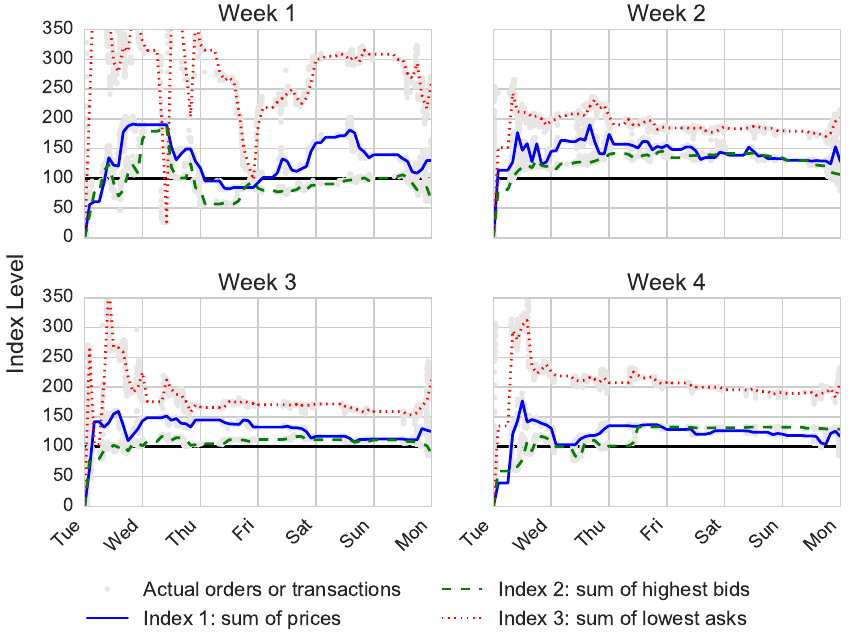
Figure A.3: Experiment 1: Evolution of the sum of all security prices for the four weeks of trading. The sum of all security prices should be 100 but there were several pronounced deviations from this normative prediction. The indices were smoothed using a 2-hour moving